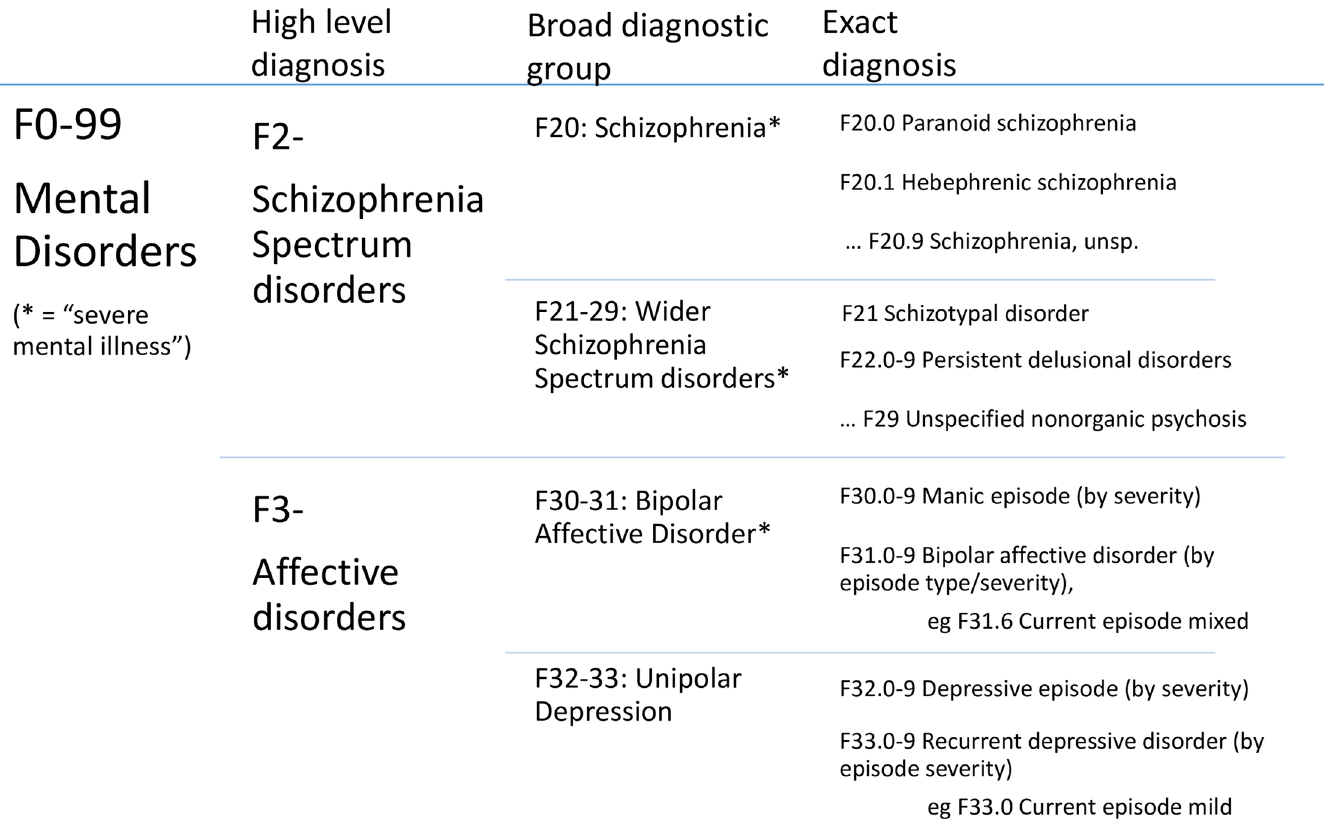
Fig 2. Hierarchy diagram showing the diagnoses considered in this study, with different levels of